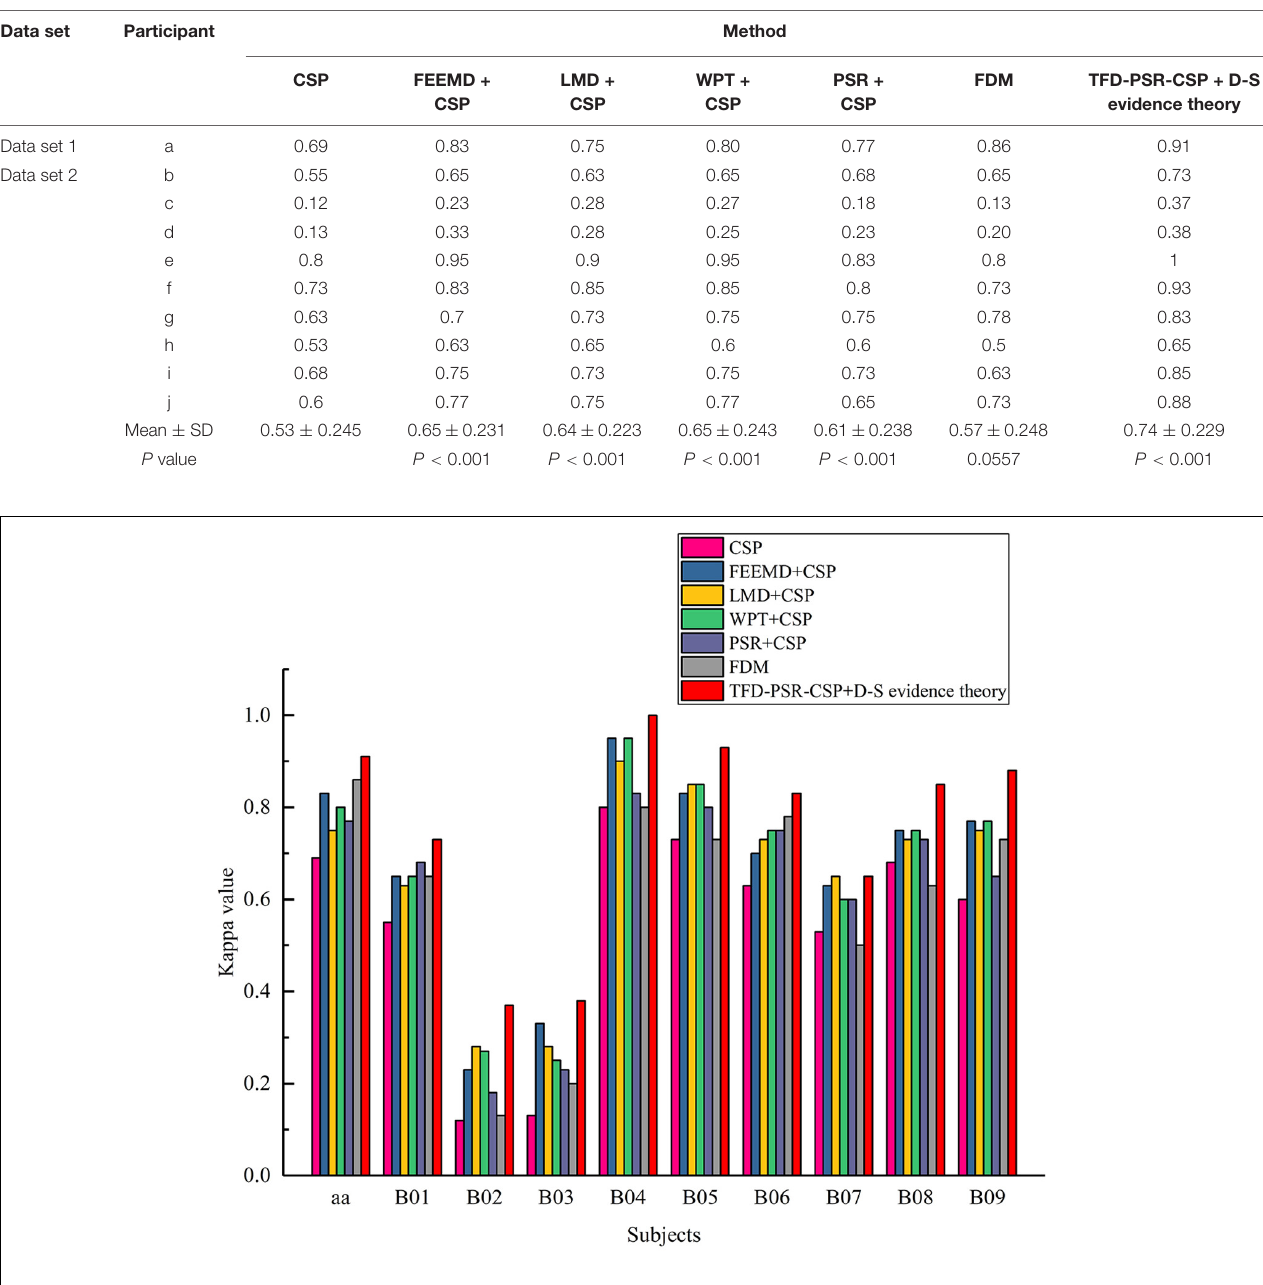
95.71% compared with the traditional CSP on data set